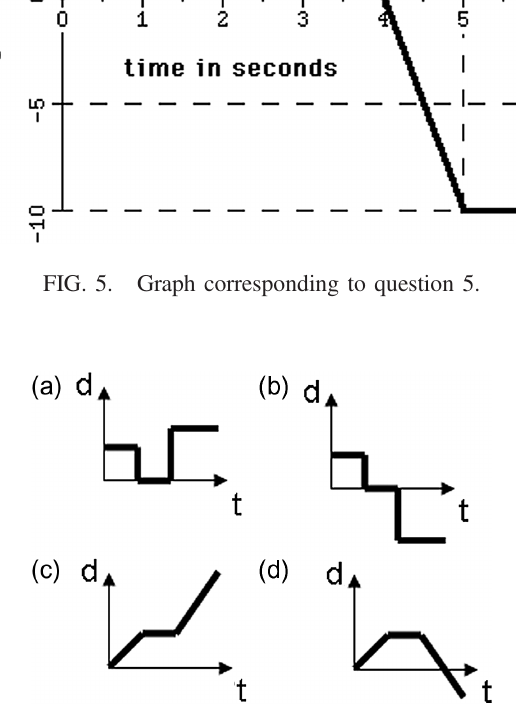
FIG. 6. Answer choices for